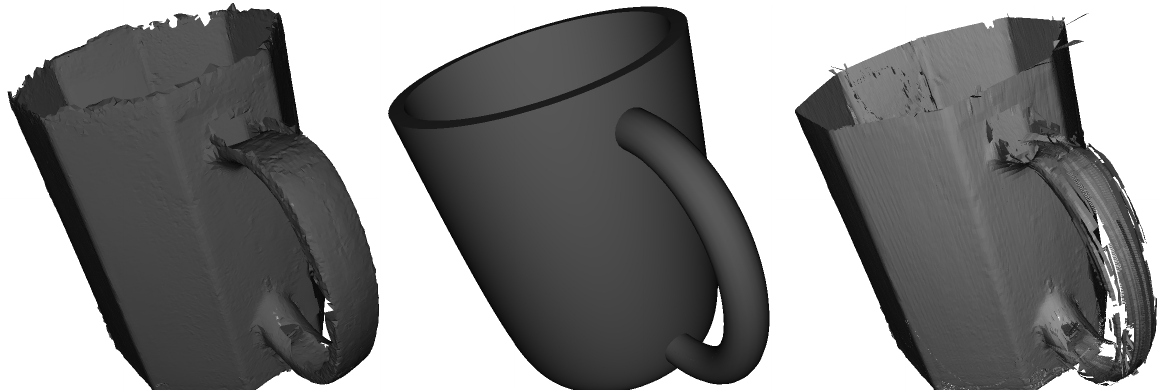
Figure 3: This figure shows the scanned model (left), the reference model (middle), as well as the output of the variance visualization (right). The reference model is defined by a set of parameters obtained in a fitting process applied on the scanned model. A subsequent variance analysis leaves us with a X3D file capable of displacing the reference mesh to match the scanned mesh as good as possible. the laser-scanned data set. An efficient ray intersection algorithm is used to obtain distance values between sample points on the reference surface and the scanned surface. These distance values are encoded in a texture and exported together with the refer- ence mesh as X3D file. An embedded displacement shader gen- erates a mesh resulting in a good representation of the actual, laser-scanned data